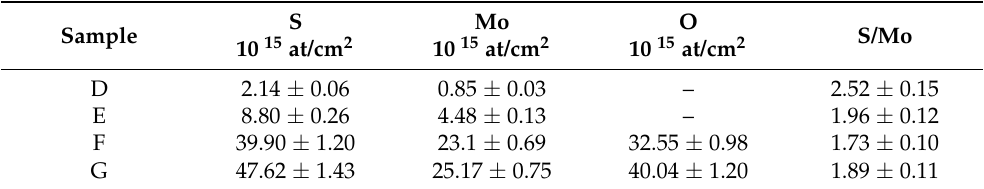
Table 3. Surface density per element (at/cm 2 ) and MoS x stoichiometry calculated from the RBS